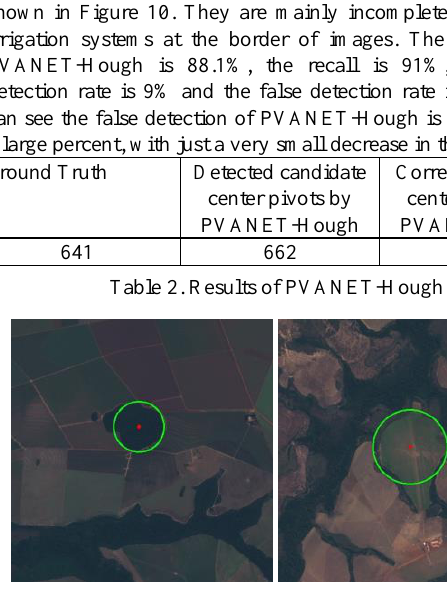
Figure 9. Examples of false detections by PVANET-Hough